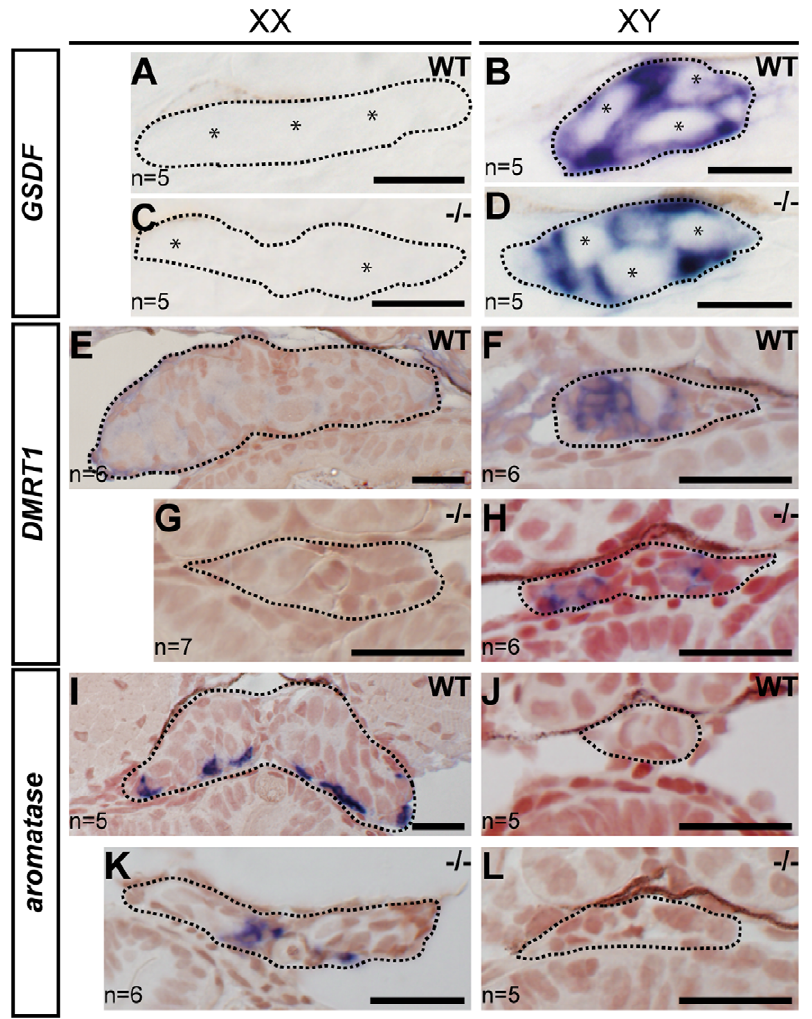
Figure 2. Early stage sex differentiation processes are unaffected in the sox9b mutant gonads. (A–L) GSDF (A–D), DMRT1 (E–H) and aromatase (I–L) expression (blue) were detected by in situ hybridization analysis of st. 39 (A–D) and 10 dph (E–L) medaka embryos, respectively. Consistent with the pattern found in wild-type (WT) medaka gonads, GSDF and DMRT1 were found to be expressed in XY gonads of the homozygous sox9b mutants, whilst aromatase was expressed in XX gonads of the homozygous sox9b mutants. More than five gonads were examined in each experiment. Dotted lines (A–L), gonadal outlines; asterisks in (A–D), germ cells. Scale bar, 10 m m (A–D); 20 m m (E–L).